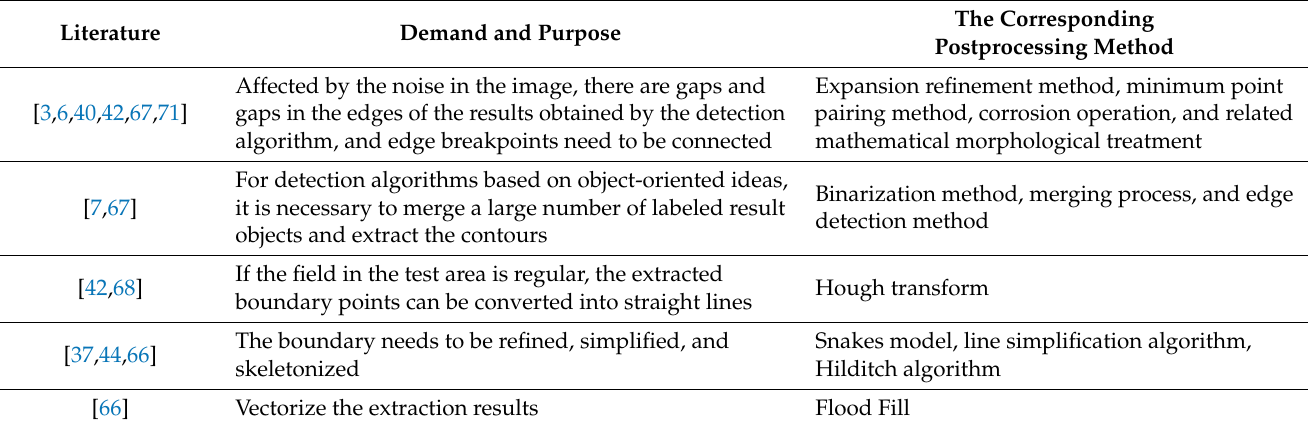
Table 4. Common requirements and corresponding postprocessing